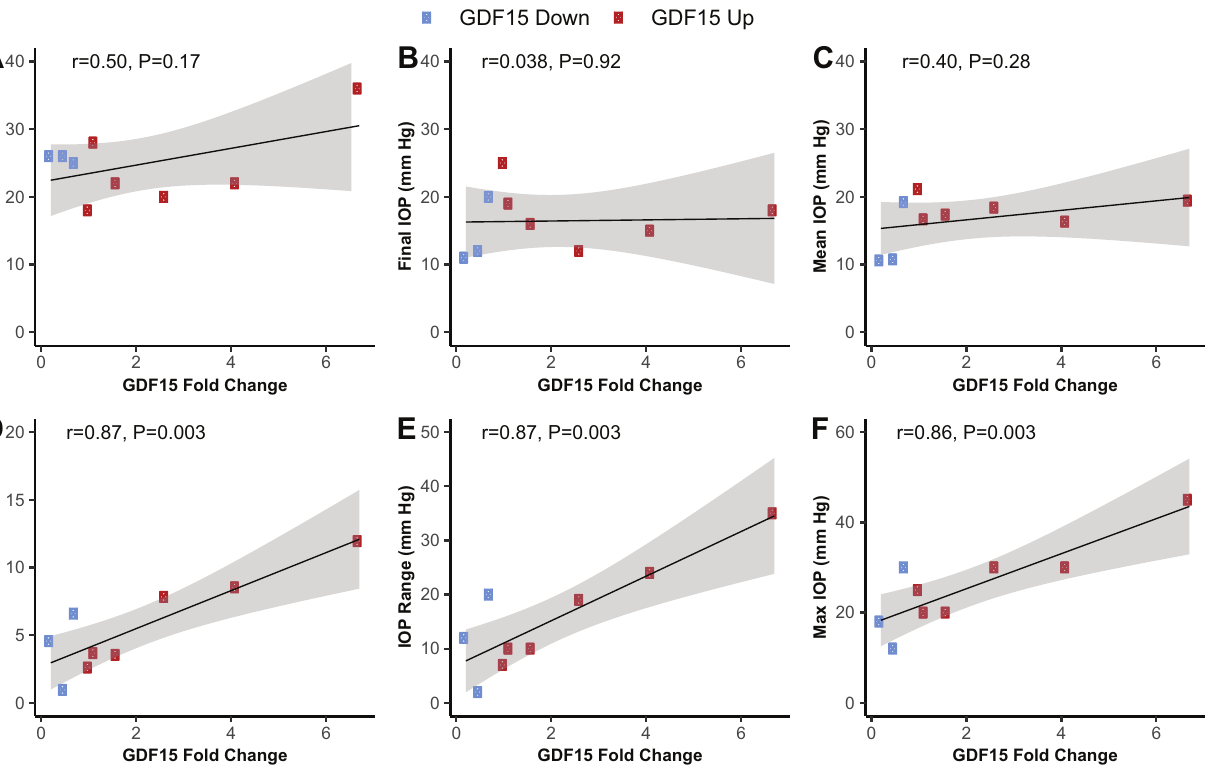
Figure 3. Aqueous humor Growth Differentiation Factor 15 (GDF15) fold change from baseline to six-month follow-up was not correlated with baseline intraocular pressure (IOP; A), final IOP (B), or mean IOP (C). In contrast, there was a strong correlation between GDF15 fold change and IOP standard deviation (stnd dev; D), IOP range (E), and maximum (max) IOP (F). r = Pearson correlation coefficients. Similar significance levels were found with non-parametric Kendall rank correlation coefficients. Shaded regions indicate 95% confidence interval bands. Circles denote patients who received the Ahmed® glaucoma valve; squares denote patients who received the Molteno® glaucoma